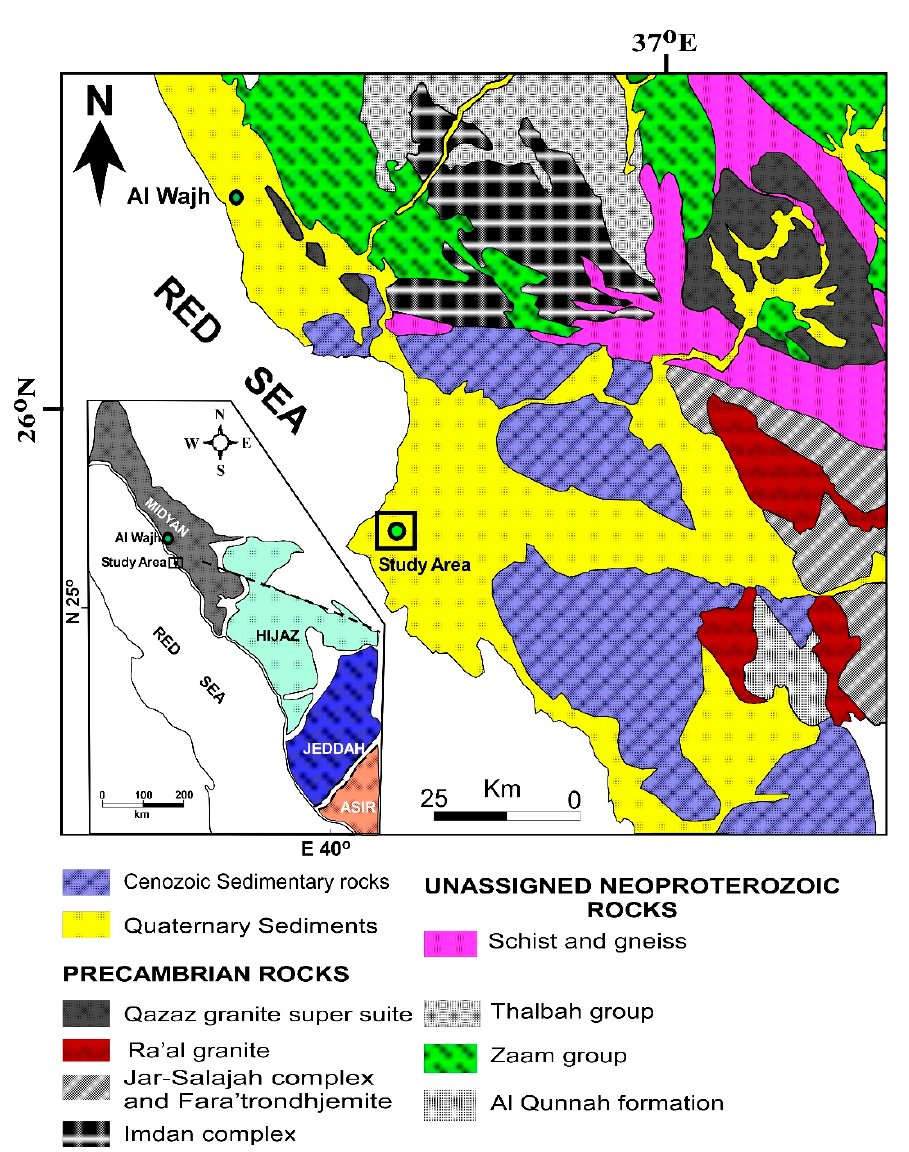
Figure 2. Simplified geologic map of the area of study (adapted from [37]) .